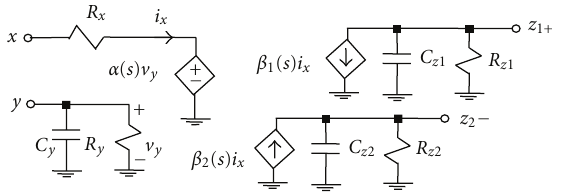
Figure 11: The nonideal MOCCII model [18]. R x = 30 Ω , R y = 17M Ω , R z 1 = 577 k Ω , R z 2 = 572k Ω , C y = 1 . 4 pF, C z 1 = 1 . 2 pF, . C z 2 = 1